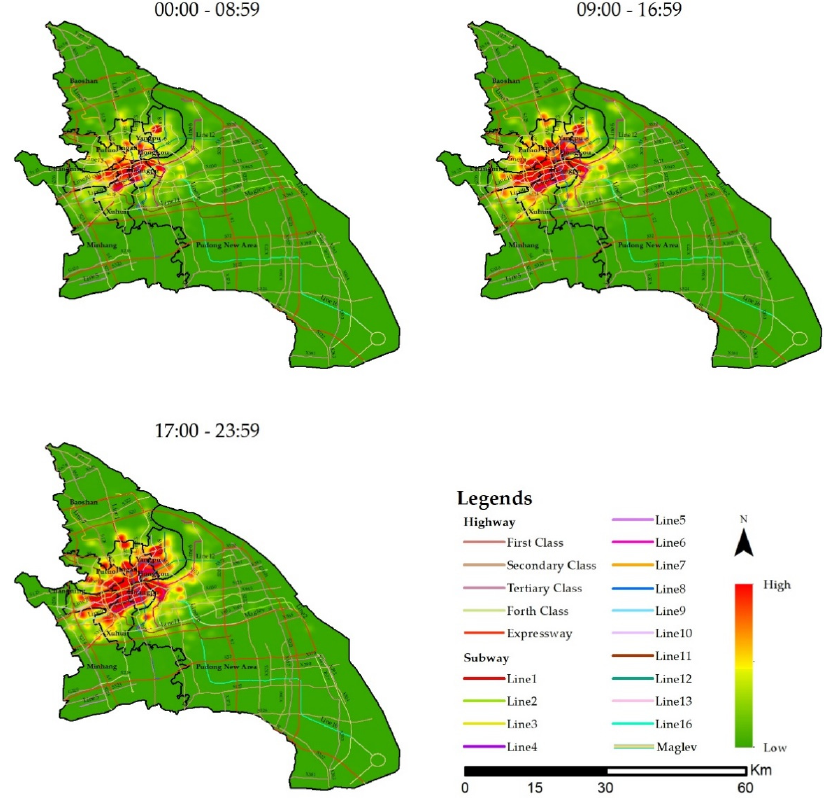
Figure 12. Check-in density of male for different hours of the Figure 12. Check ‐ in density of male for different hours of the day.